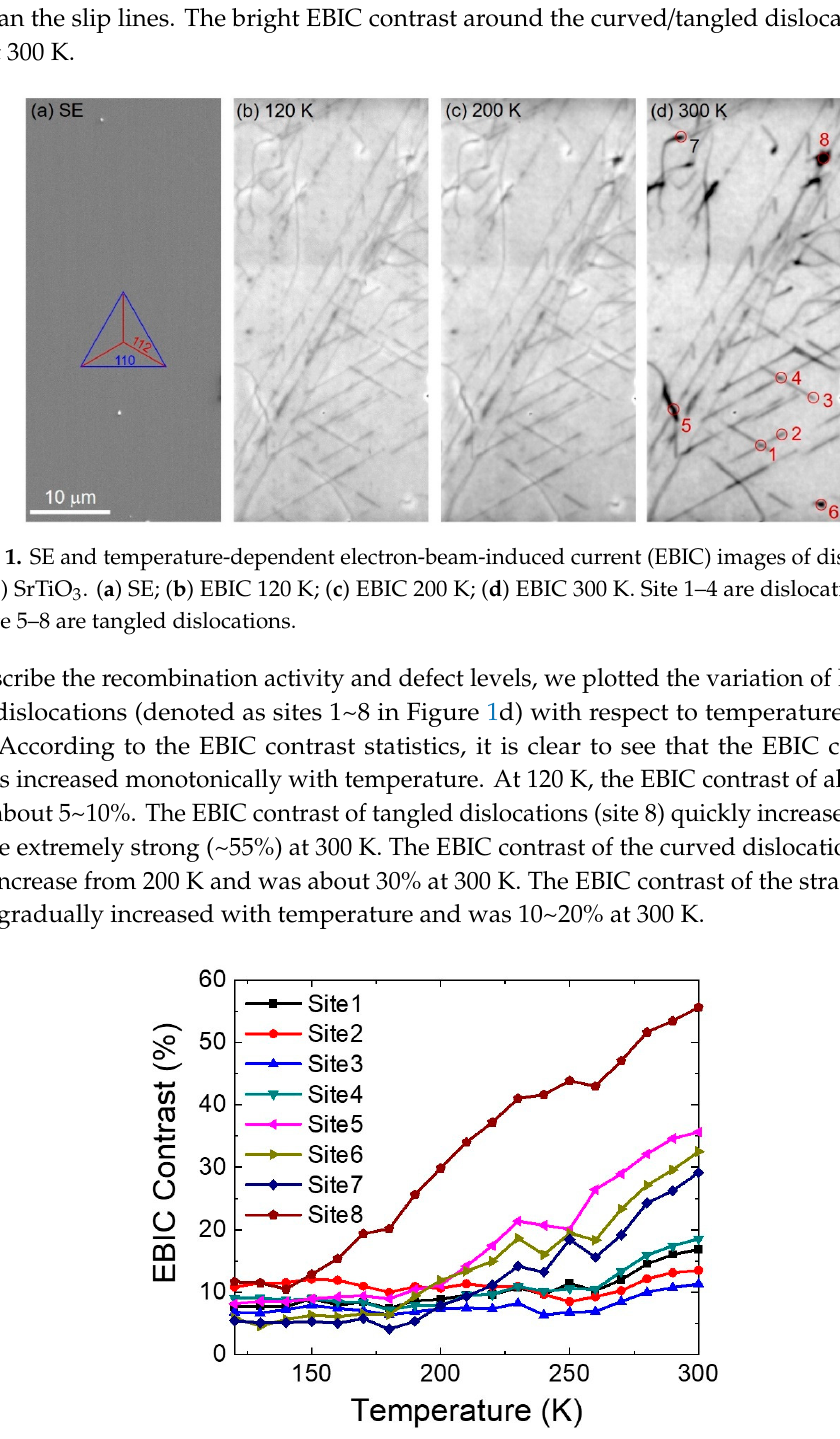
Figure 2. Variation of EBIC contrast of dislocation related defects with respect to temperature. The different sites were denoted by 1~8 in Figure